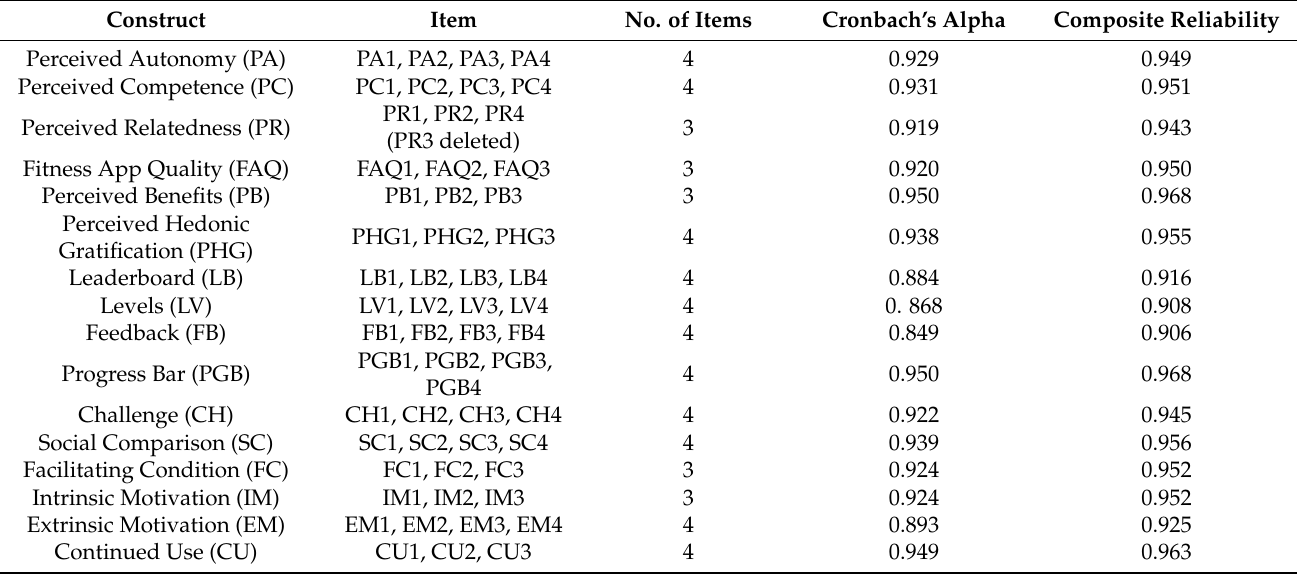
Table 3. Reliability analysis for each